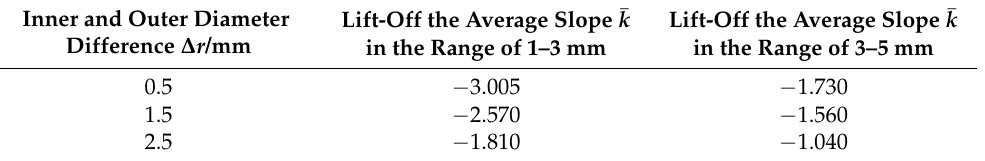
Table 2. The average slope of the measured signal when the coil is detected with different inner and outer diameters difference.